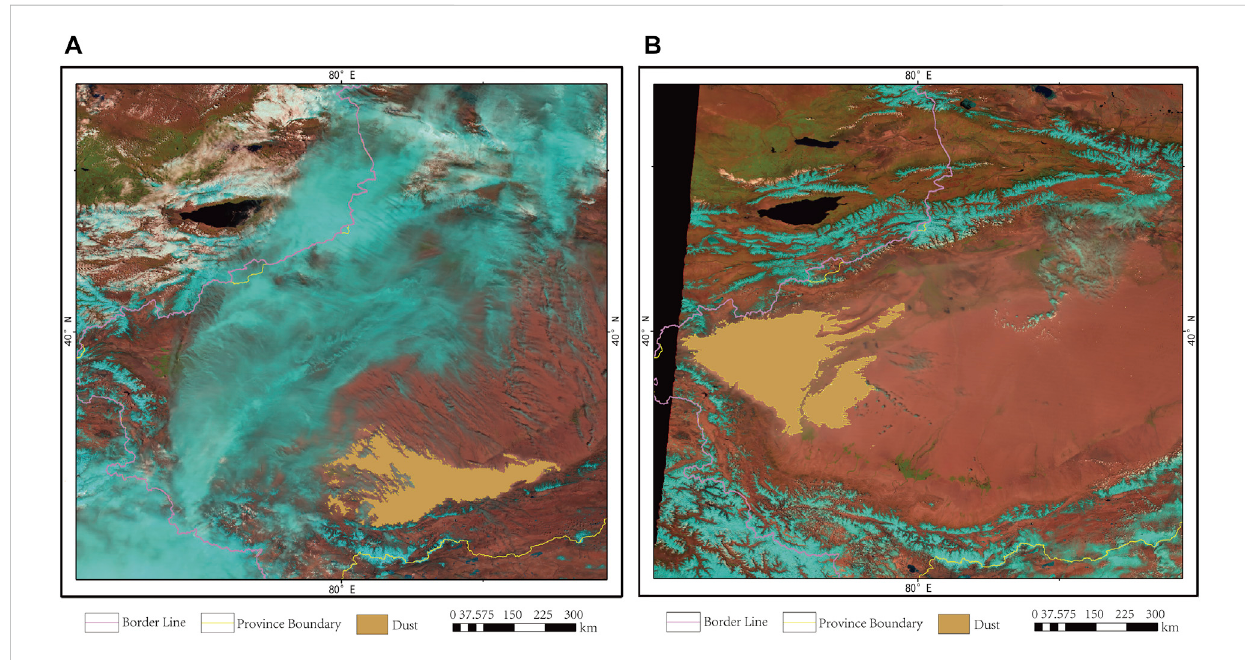
FIGURE 5 EOST/MODIS monitor of dust in the south region of Xinjiang at 13:13 on April 27 (A) and 13:01 on April 29 (B)